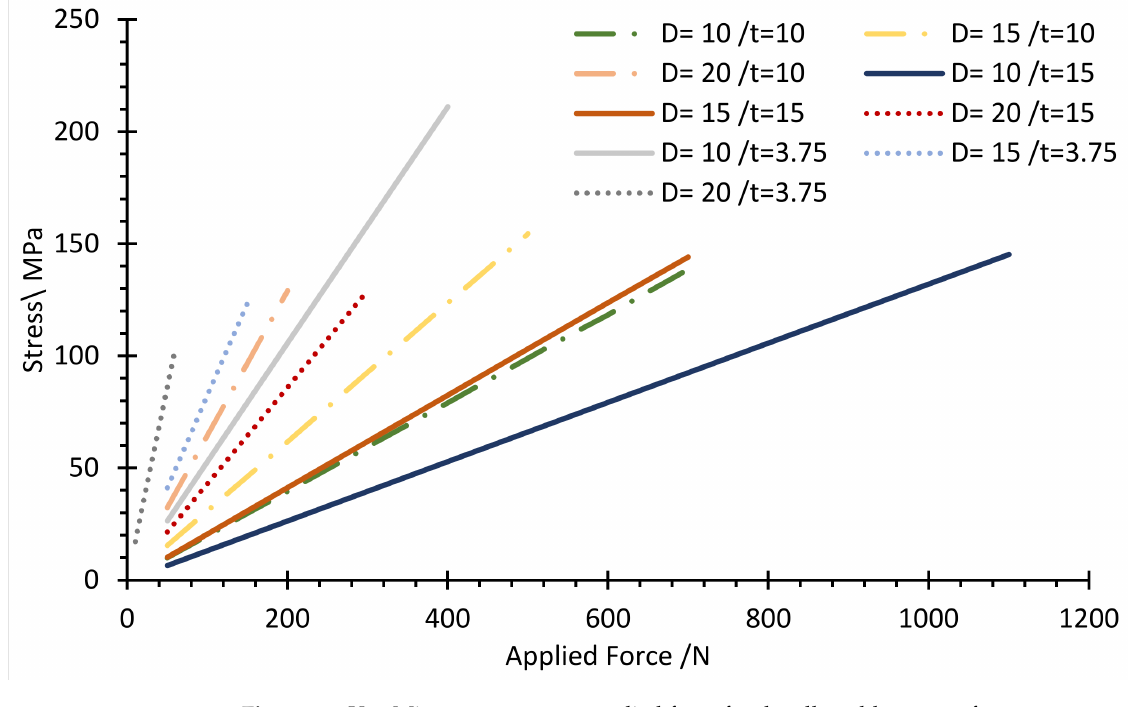
Figure 10. Von Mises stress versus applied force for the allowable range of parameters.